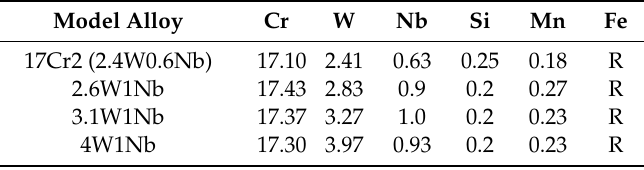
Table 1. Compositions of the base (17Cr2) and the high W / high Nb model alloys, wt.%. Model Alloy Cr W Nb Si Mn Fe 17Cr2 (2.4W0.6Nb) 17.10